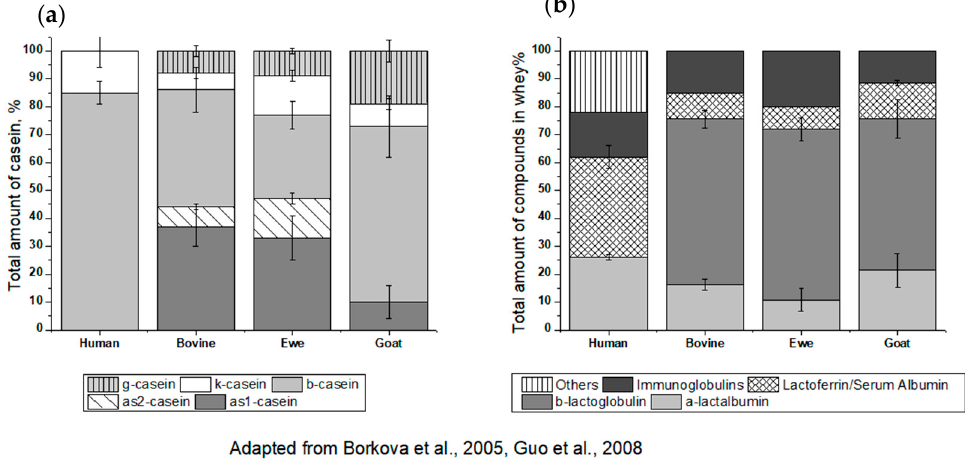
Figure 2. ( a ) Representation of caseins in human, raw bovine, ewe, and goat’s milk. ( b ) Composition and content of whey proteins in human, skimmed cow, ewe and goat’s milk adapted from [15,16]. Table 1. Characteristics of main cow’s milk allergens [13,17] and IUIS Allergen Nomenclature. Conc. Milk Proteins